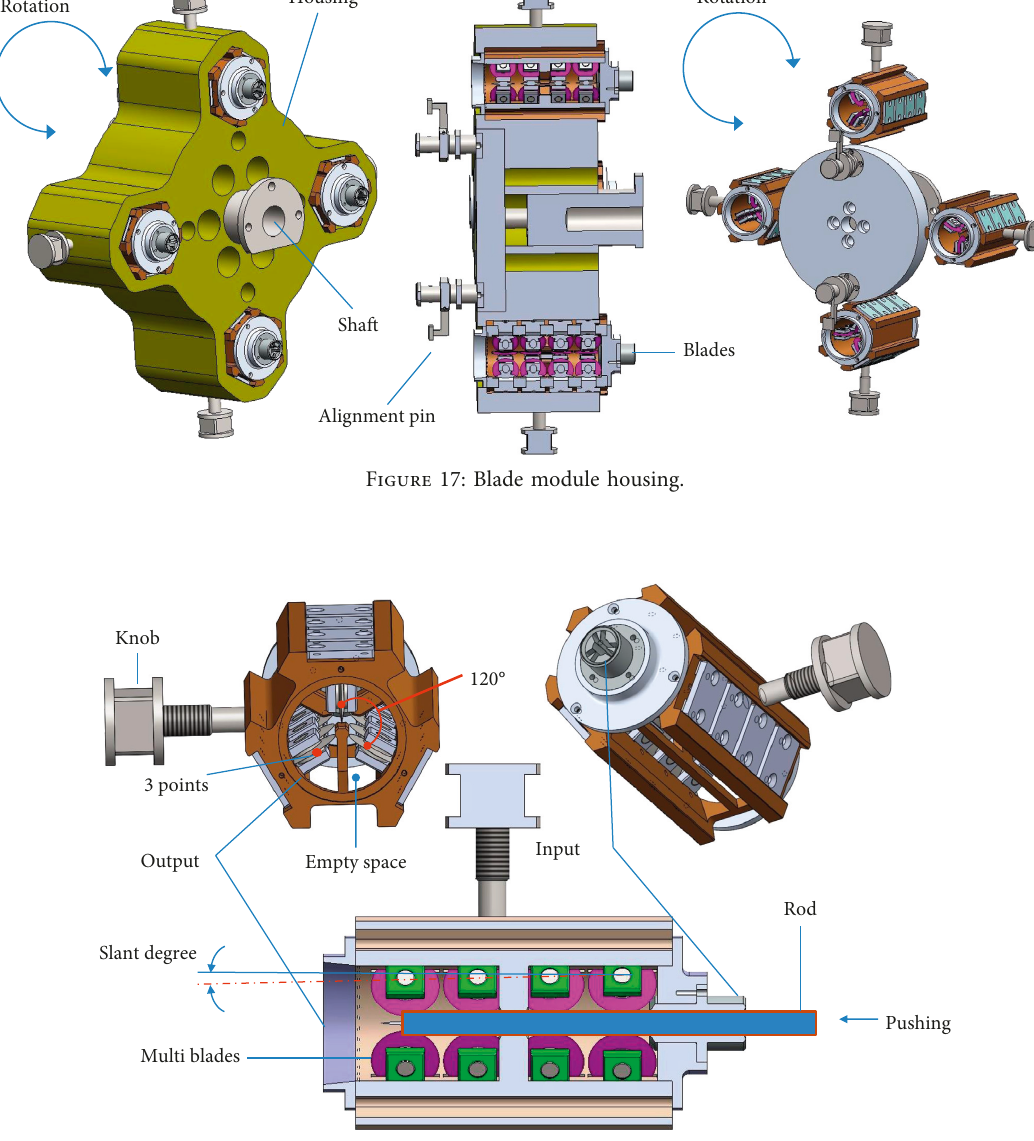
Figure 18: Schematic of 3-CUT blade